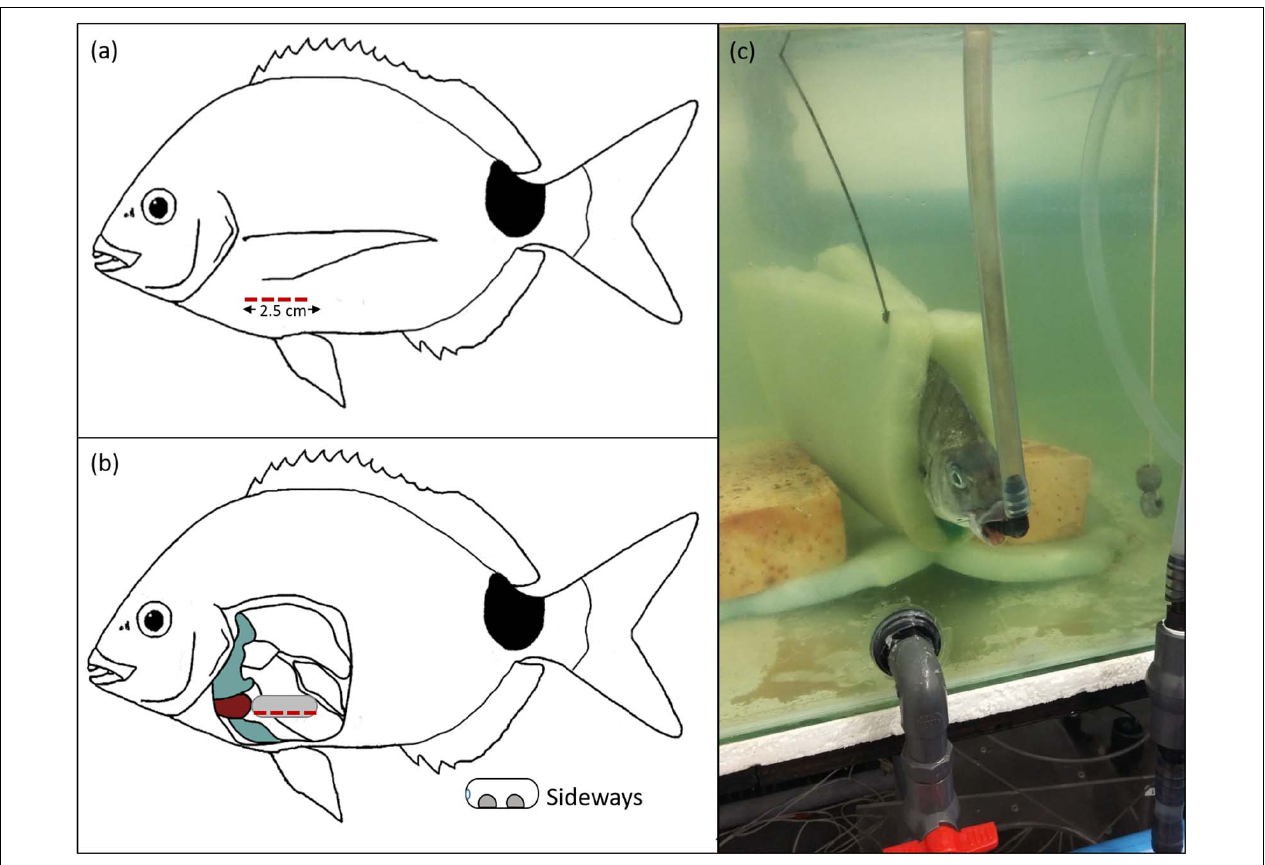
FIGURE 2 | The position of the incision made on the individual adult sparid Diplodus capensis for the insertion of the Star-Oddi © micro HRT heart rate logger as well as the position of an individual adult D. capensis maintained throughout experiments. The position of the incision (red dashed line) was made directly below the origin of the left pectoral fin (a) relative to the pericardium (red), pelvic and pectoral girdles (gray) within the abdominal cavity for the insertion of the Star-Oddi © micro HRT heart rate logger orientated sideways (b) . Sideways orientation was positioned at a 45 ◦ angle ventrally and in direct contact with the musculature. The position maintained throughout experiments for individual D. capensis was in an upright position in a weighted sling with a respiratory inflow valve (c)